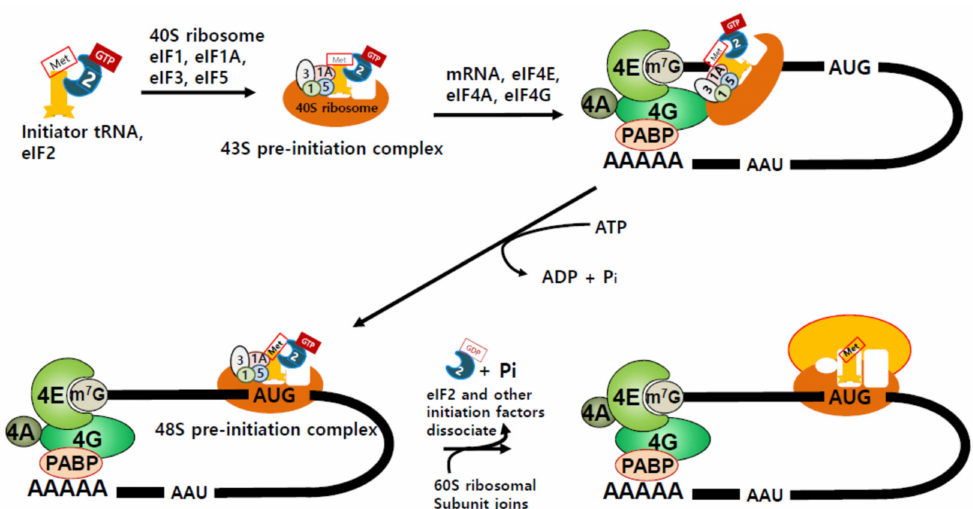
Figure1. Cap-dependenttranslationinitiation. WhenaninitiatortRNAbindstoguanosinetriphosphate (GTP)-bound eukaryotic initiation factor (eIF2), the complex can further recruit eIF1, eIF1A, eIF3, eIF5, and 40S ribosome to form 43S pre-initiation complex (43S PIC). eIF4F, composed of eIF4A, eIF4E, and eIF4G, facilitates the recruitment of mRNA to 43S PIC. Then, eIF4E binds to the 5 (cid:48) -cap of mRNA, and eIF4G recruits poly(A)-binding protein (PABP), which binds to poly(A) on mRNA on the 3 (cid:48) -end, thus circularizing the mRNA to stabilize it for translation. eIF4A functions as a helicase and may facilitate mRNA scanning to find the initiation codon AUG. Once the codon is found by 43S PIC, eIFs are released and the 60S ribosomal subunit joins the assembly to generate protein synthesis-ready 80S ribosome ready for translation